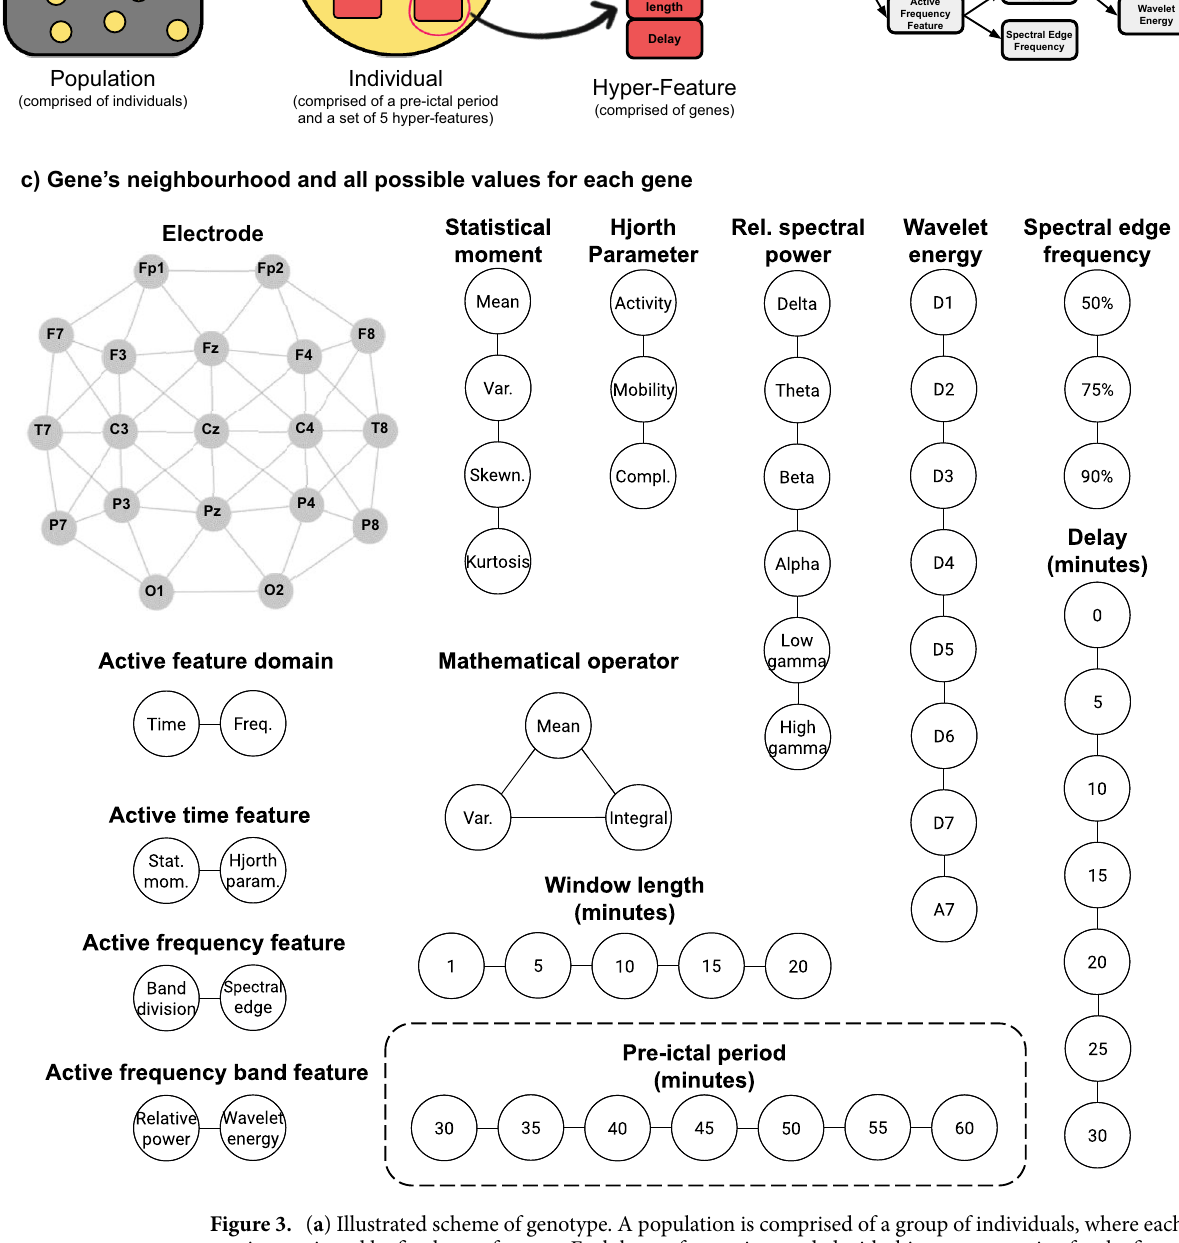
Figure 3. ( a ) Illustrated scheme of genotype. A population is comprised of a group of individuals, where each one is constituted by five hyper-features. Each hyper-feature is encoded with thirteen genes: nine for the first- level feature, as well as delay, electrode, mathematical operator, and window length. ( b ) Active feature decoding, or in other words, how to decode the first-level feature from the genotype. ( c ) Gene’s neighbourhood and all possible values for each gene, which allows the application of variation